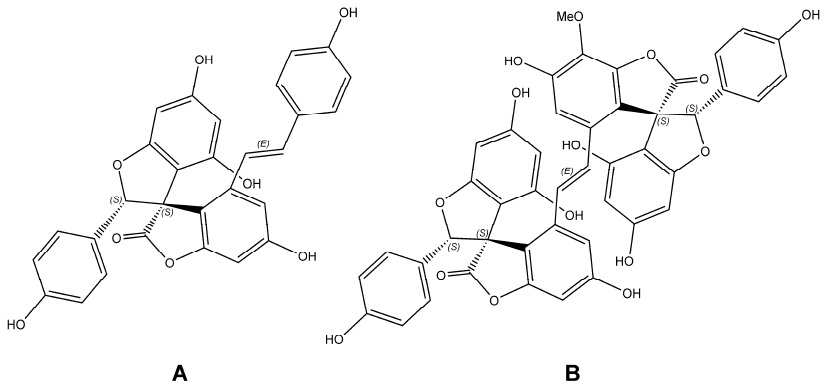
Figure 1. The structure of spiro-flavostilbenoids: ( A ) Yuccaol B (YuB); ( B ) Gloriosaol A